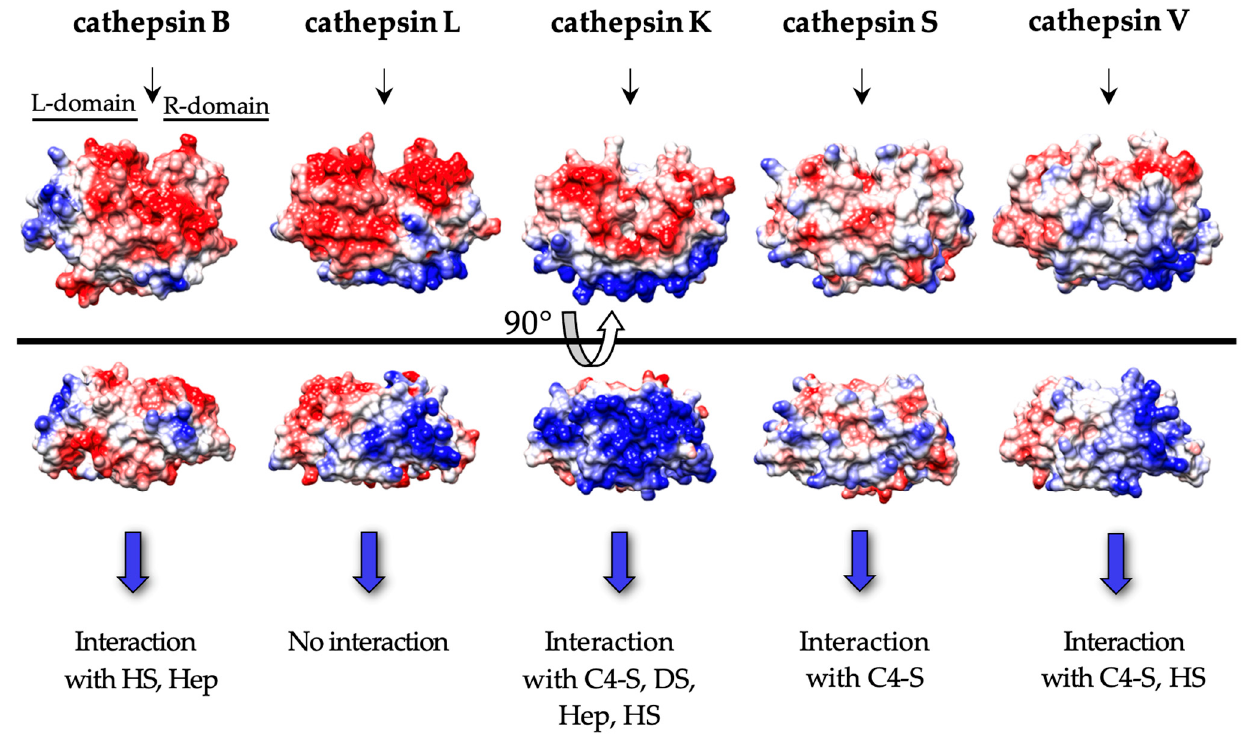
Figure 4. Electrostatic surface potential of cathepsins B, L, K, S, and V. Surface potential representation of cathepsins B (pdb: 1HUC), L (pdb: 2NQD), K (pdb: 1C9E), S (pdb: 1NPZ), and V (pdb: 1FH0) was generated with UCSF Chimera software. The surface colors are fixed at red ( − 10) or blue (+10); negative charges are shown in red and positive charges are shown in blue. Active site is represented by a black arrow. References for GAG–cathepsin interactions are noted.